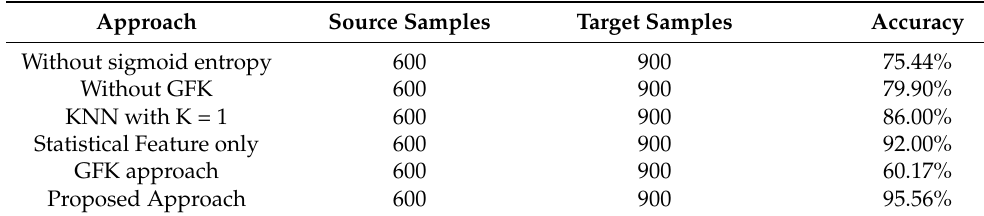
Table 2. Experiment Results